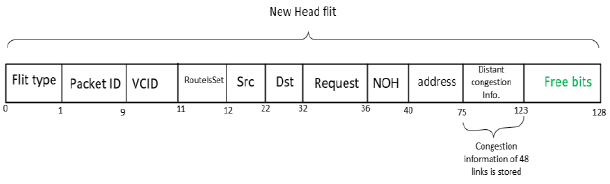
Fig. 5. A new head flit structure for implementation of the proposed